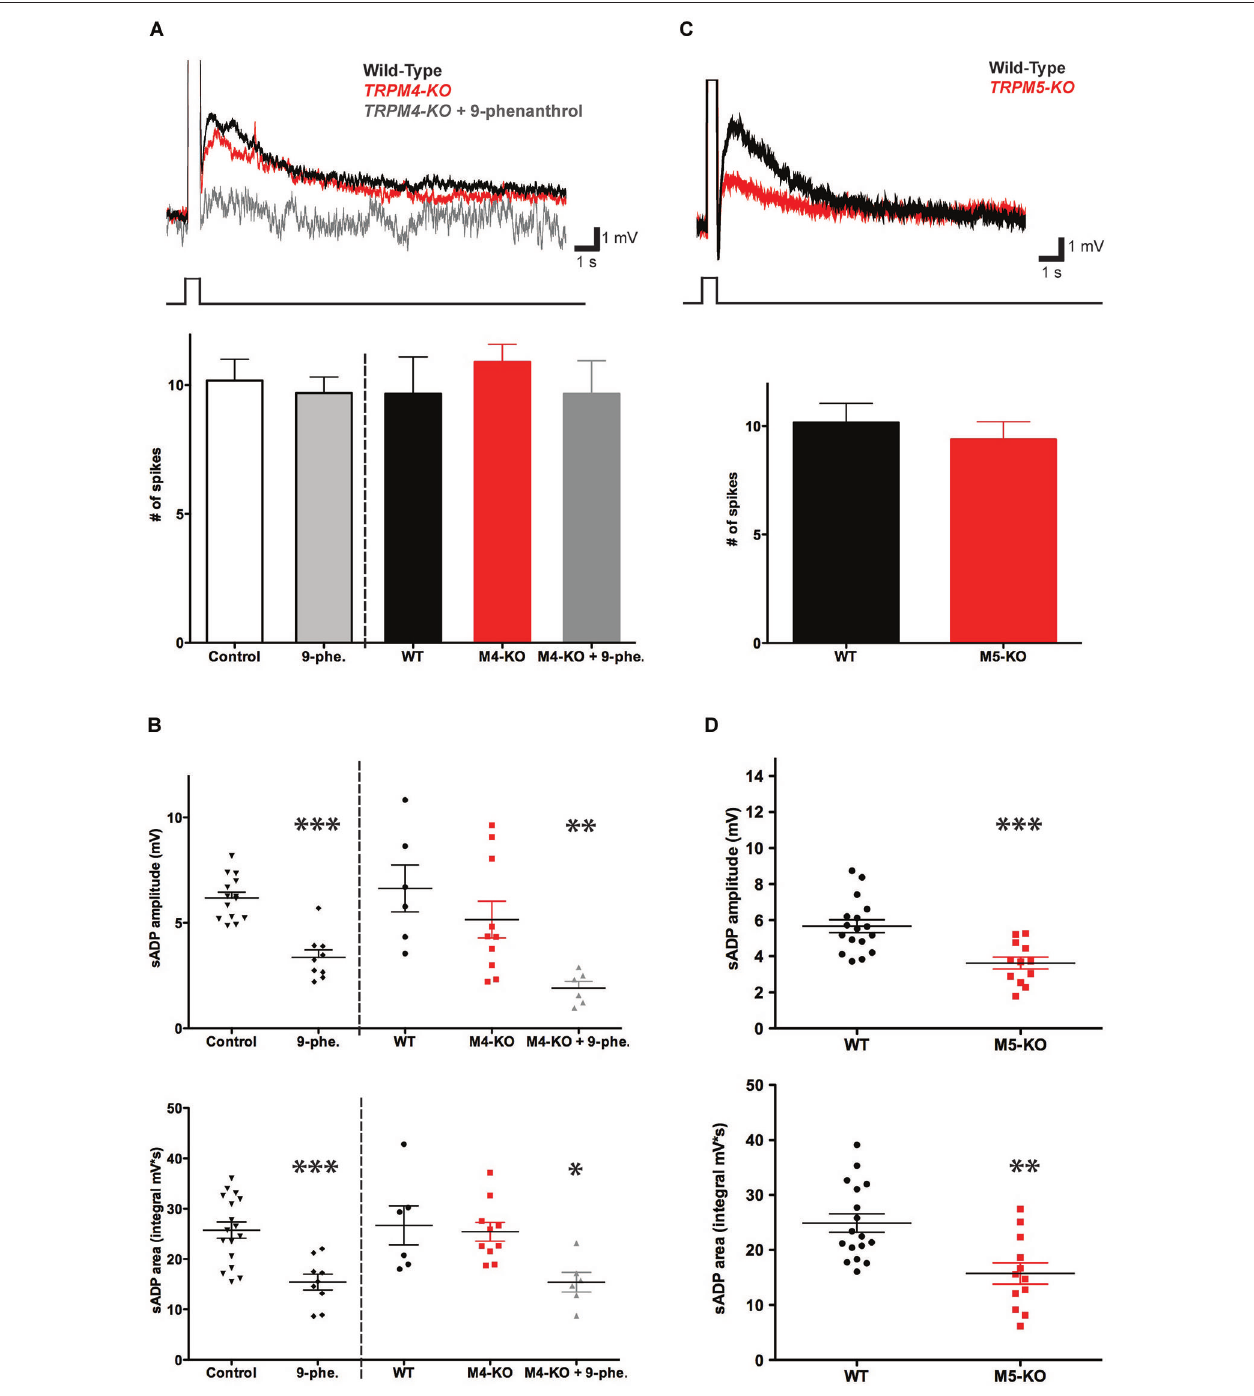
0.71). There were no significant differences in number of spikes among wild-type (WT) mice or Trpm4 − / − mice (M4-KO) under control conditions or in presence of 9-phenanthrol (M4-KO + 9-phe.); n = 6–11, P = 0.39 and P = 1 respectively. (B) Genetic deletion of TRPM4 did not significantly reduce sADP amplitude (top graph; n = 6–10, P = 0.31) or sADP area (bottom graph; n = 6–10, P = 0.74). However, application of 9-phenanthrol in both control and Trpm4 − / − mice decreased significantly peak sADP